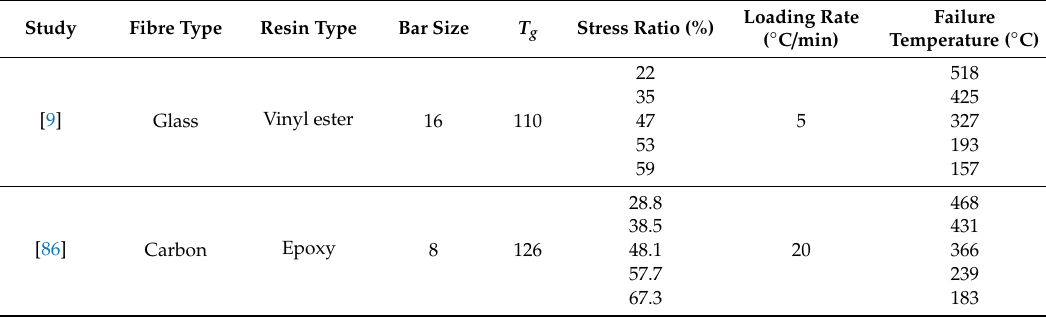
Figure 3. FRP bars tensile strength versus critical temperature reported in the literature. Table 2. FRP bars subjected to elevated temperatures (transient state tensile